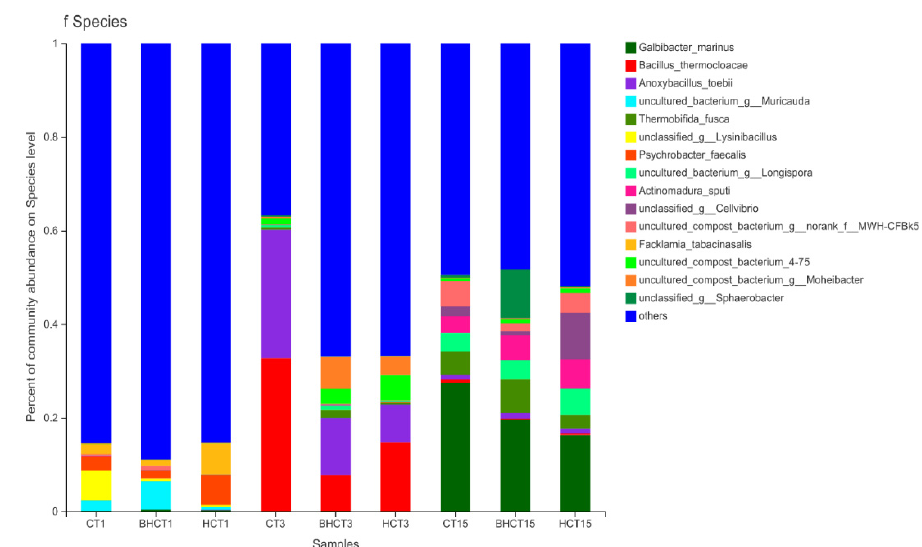
Figure 2. The distribution histogram of the relative abundance of heavy-metal-resistant bacteria from the phylum to species level: ( a ) phylum, ( b ) class, ( c ) order, ( d ) family, ( e ) genus and ( f ) species.